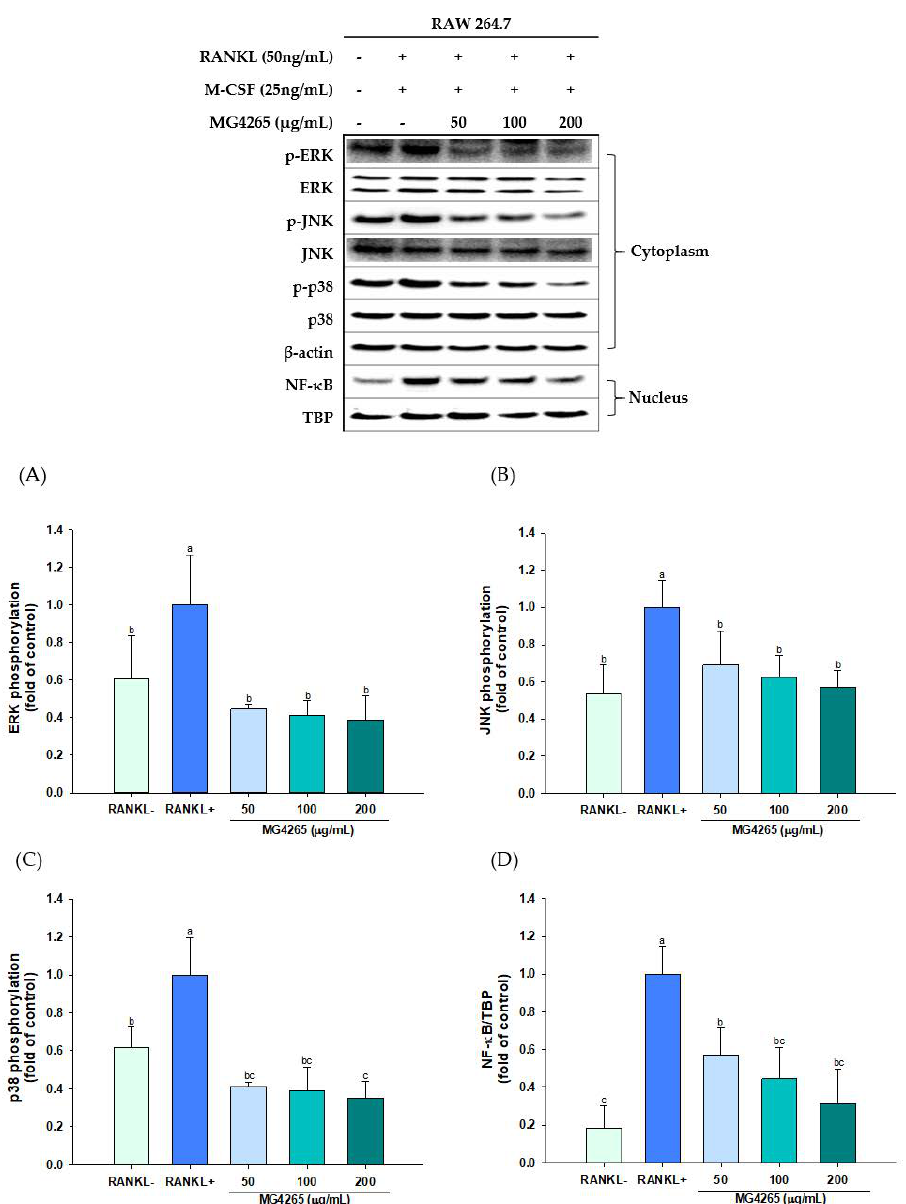
matory bone damage [49,53].